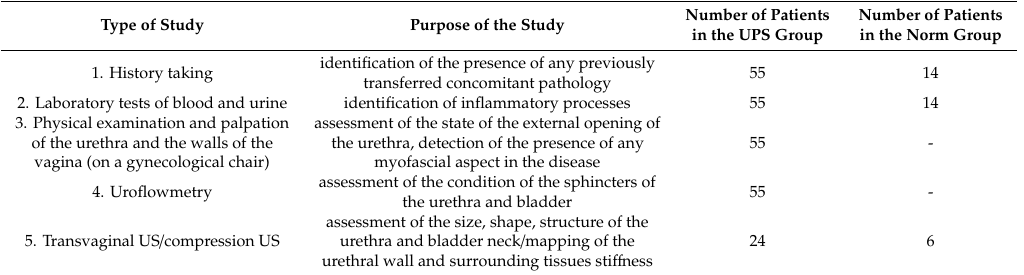
Table 1. Clinical and laboratory methods for patient’s examination and number of included